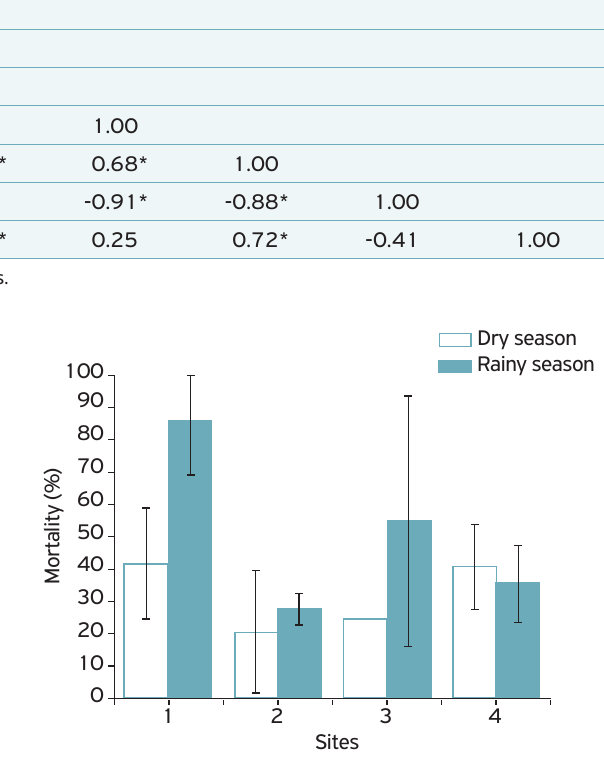
Figure 1. Mortality of Lecane bulla in water in different season and sites of Atibaia